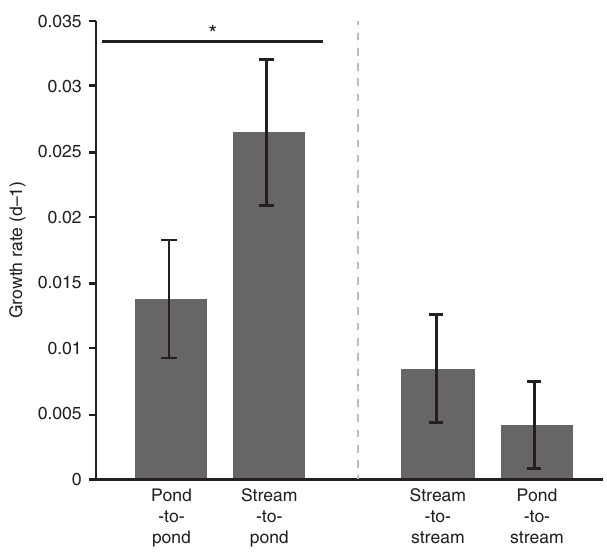
Figure 7 | Mean growth rate for each group of larvae from the reciprocal transfer experiment. Error bars represent 95% confidence levels, and asterisks denote statistically significant differences determined by